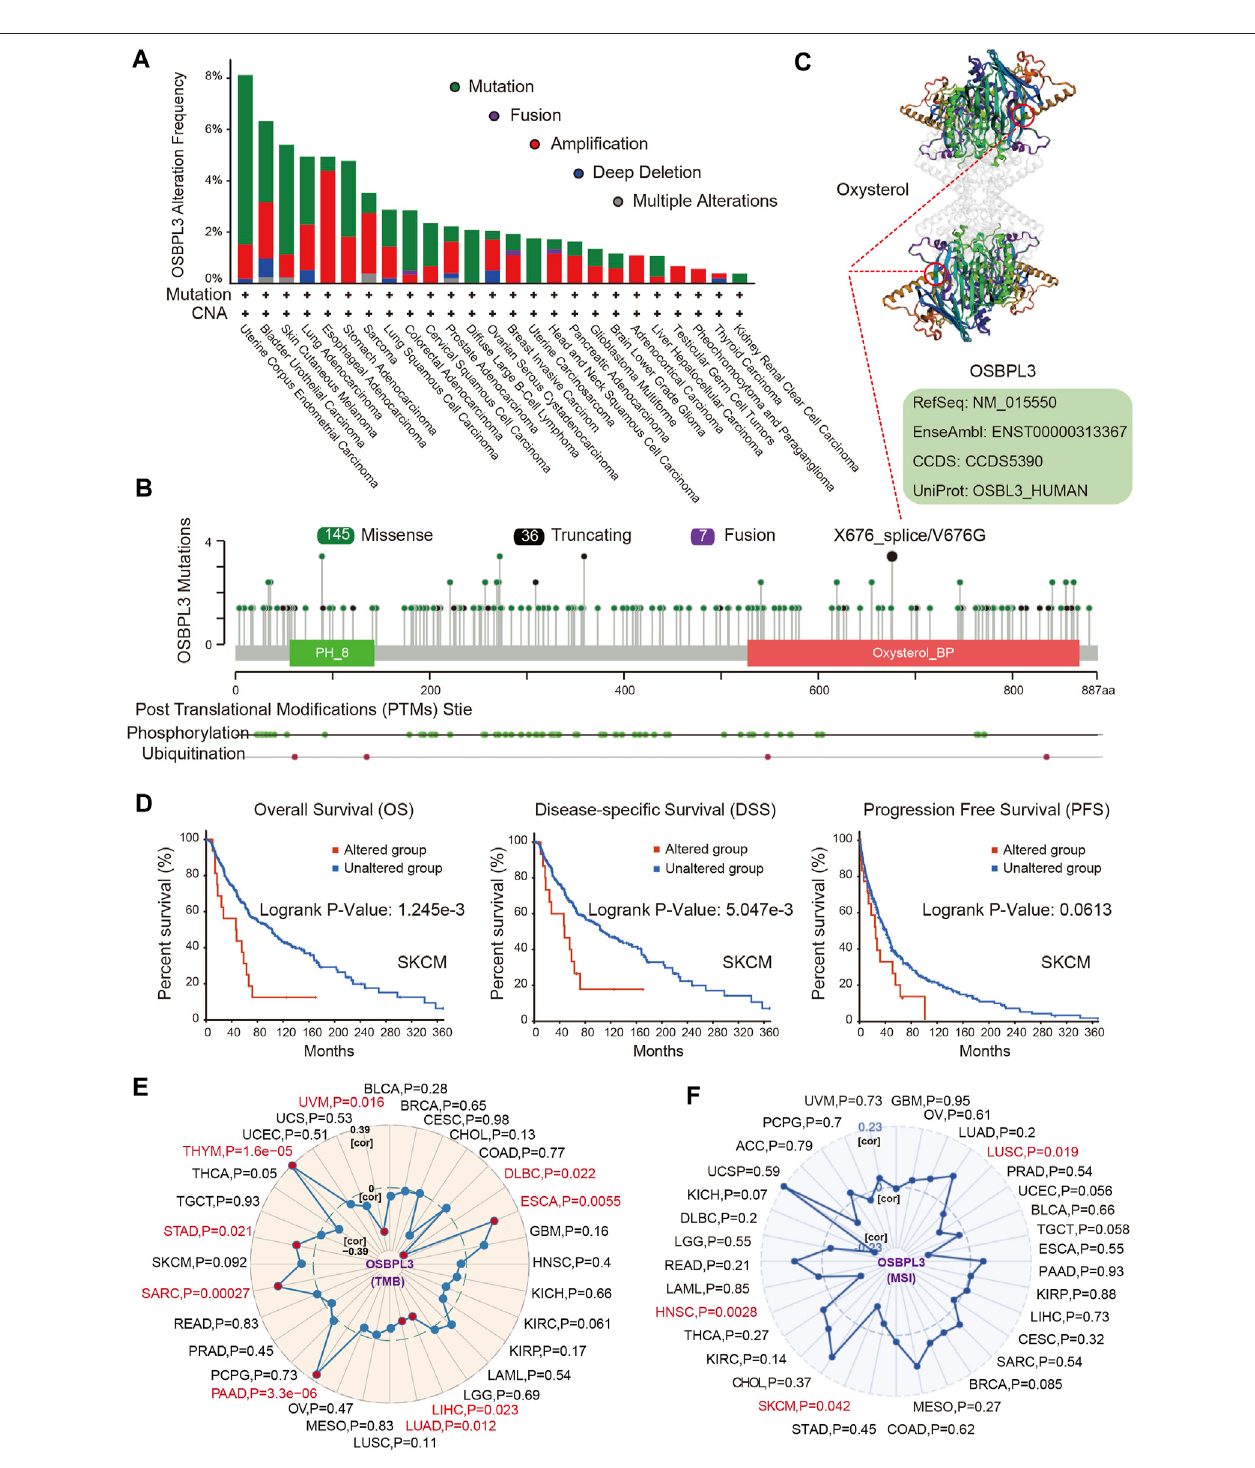
FIGURE 6 | Alteration feature of OSBPL3 and correlation between OSBPL3 expression and tumor mutational burden (TMB)/microsatellite instability (MSI) in differenttumorsofTCGAonthecBioPortaldatabase. (A) AlterationfrequencywiththemutationtypeofOSBPL3. (B) AlterationwiththemutationsiteofOSBPL3. (C) 3D structureofthemutationsiteofOSBPL3withthehighestalterationfrequency(X676_splice/V676G). (D) CorrelationbetweenthemutationstatusofOSBPL3andoverall, disease-speci fi c,andprogression-freesurvivalofSCMcancer. (E – F) CorrelationbetweenOSBPL3expressionandTMB (E) /MSI (F) withdifferenttumorsofTCGA. The p -value is